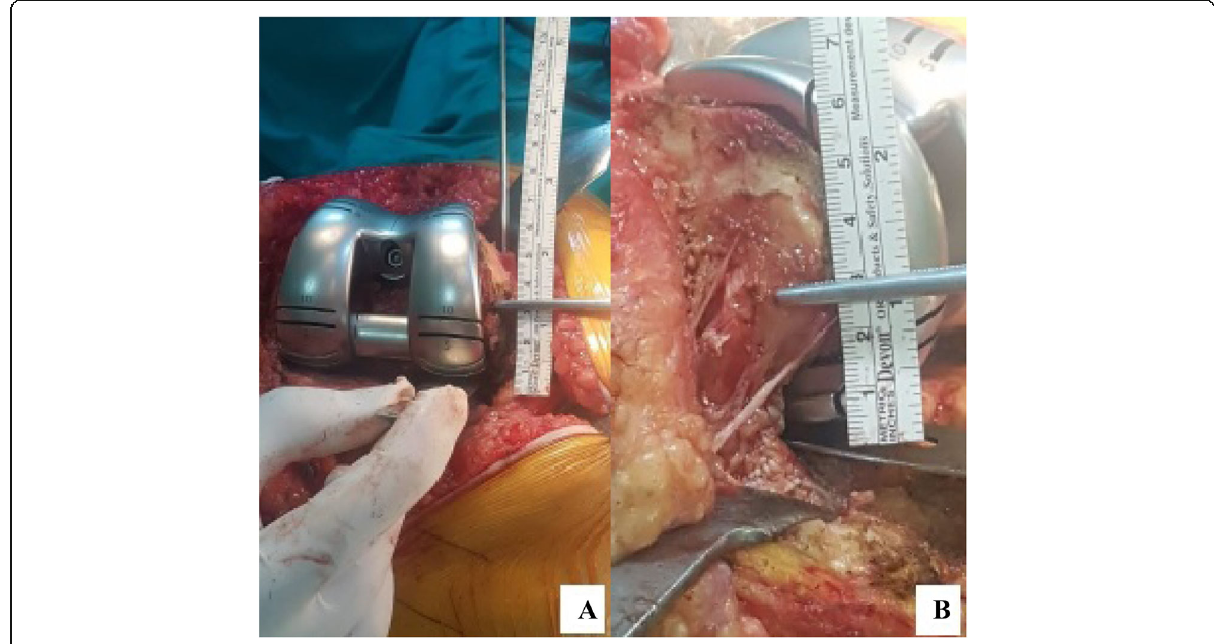
Fig. 3 Posterior joint line restorations with femoral trial prothesis according to calculations. a. ME-PJL. b. LE-PJL